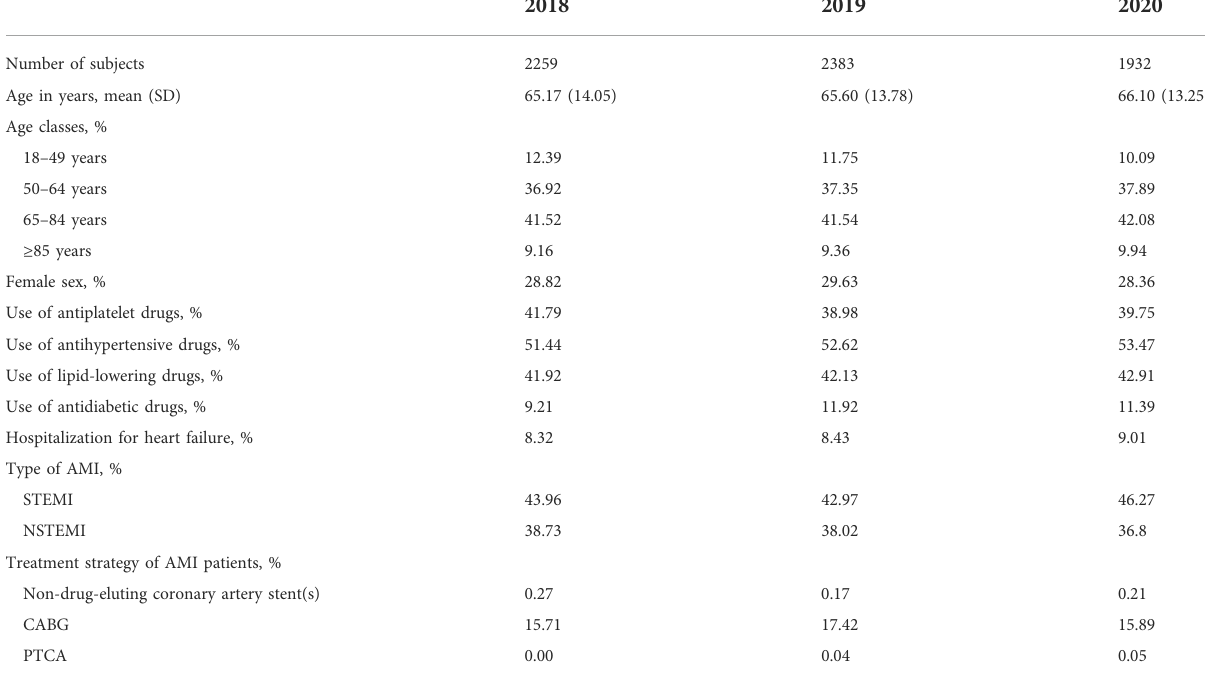
TABLE 1 Characteristics of the cohorts in the quarters February-March-April.